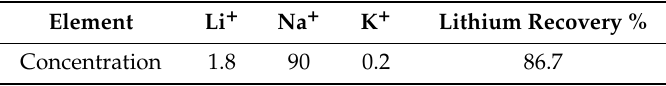
Table 8. The main parameters of the mother liquor (g · L − 1 ). Table 9. The chemical composition of the prepared Li 2 CO 3 .